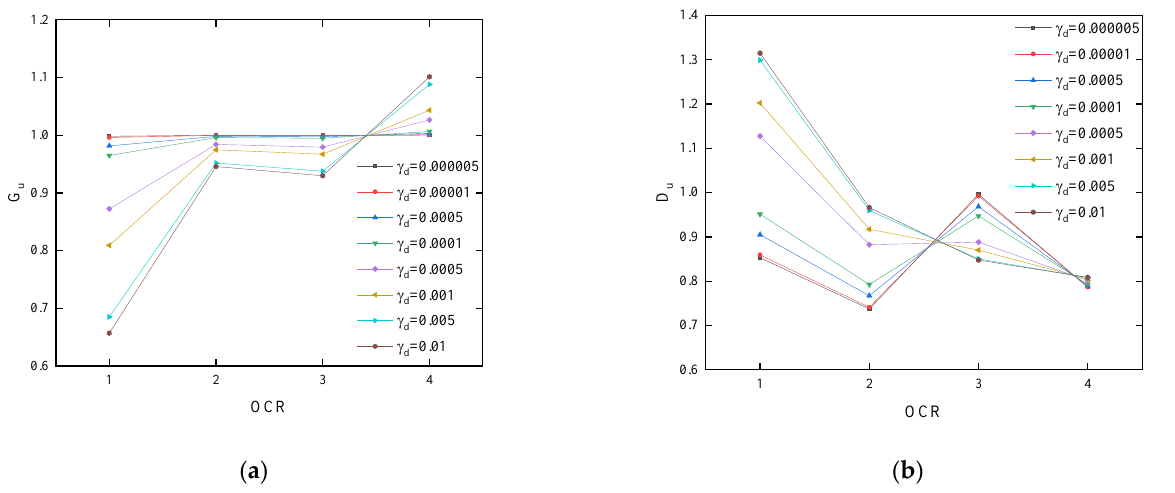
Figure 13. Influence of the OCR on the dynamic shear modulus ratio and damping ratio: ( a ) the relationship between G u and OCR and ( b ) the relationship between D u and OCR.